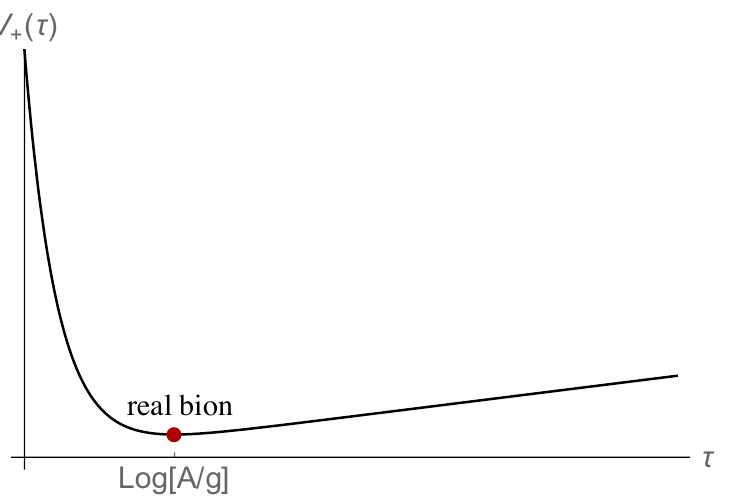
( (cid:28) ) associated with the [ II ] con(cid:12)guration. The +